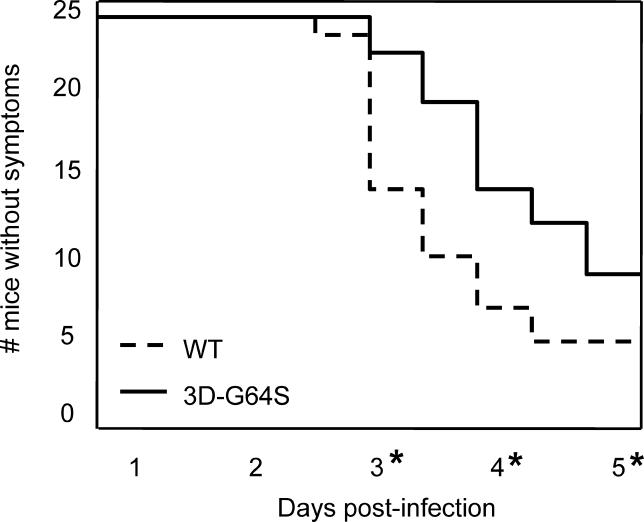
Pathogenesis of Wild-Type and 3D-G64S Viruses in PVR MicePVR mice were given IM injections with 5 × 106 PFU of either the wild-type or 3D-G64S viruses and were monitored for symptoms of disease. Mice were scored as having symptoms when weakness was first observed in the inoculated limb. Asterisks denote time points where statistically significant differences (p < 0.05, determined by two-sample Student's t-test [d 3, 0.0025; d 4, 0.0053; d 5, 0.043]) were observed between 3D-G64S and wild-type viruses.DOI: 10.1371/journal.ppat.0010011.g001